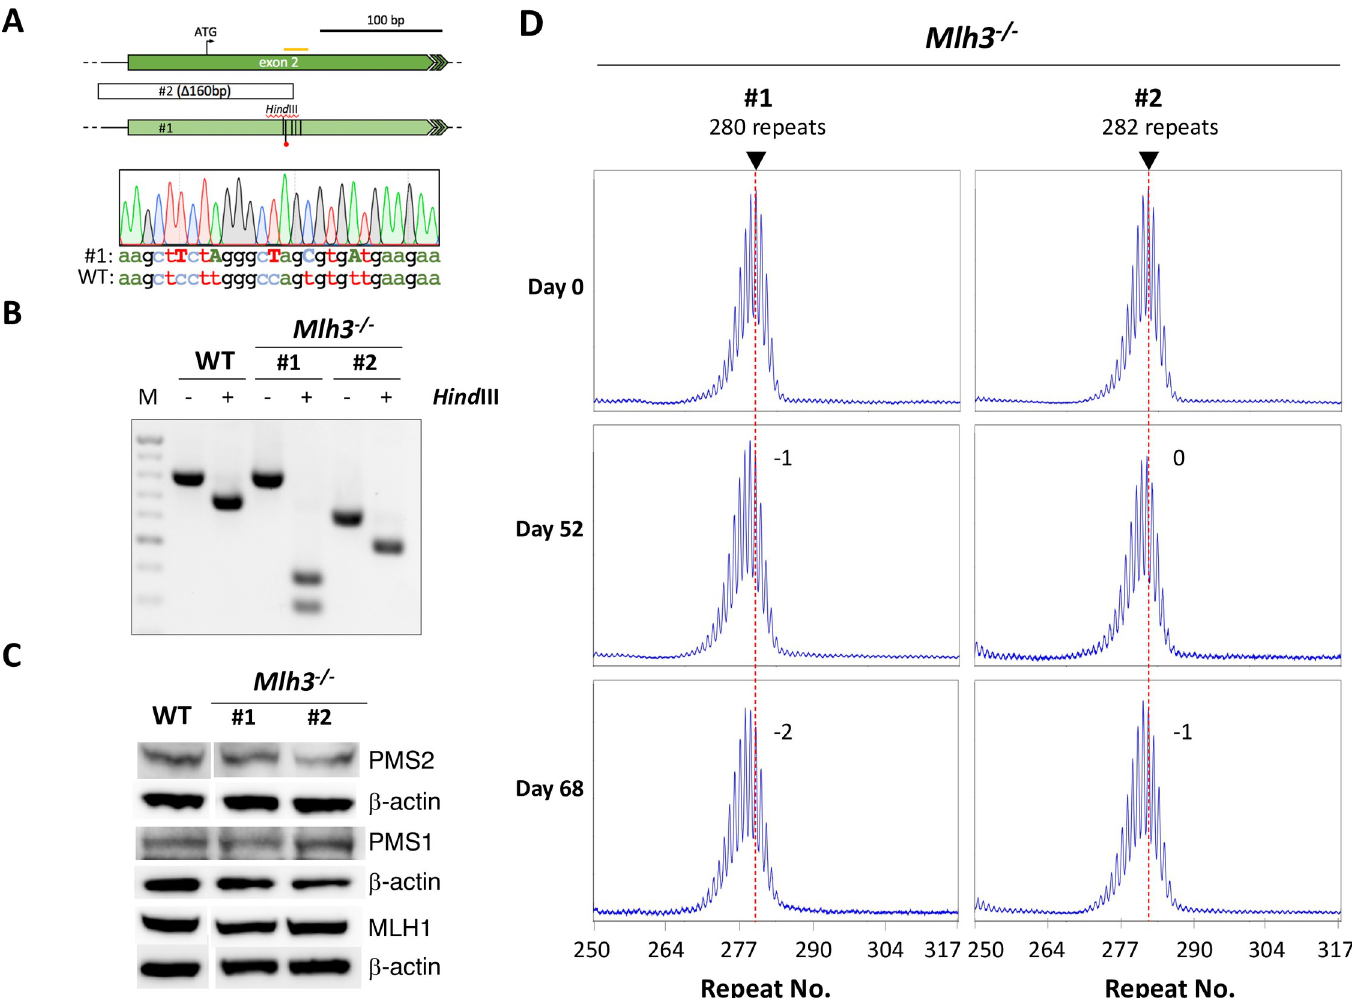
Fig 2. Generation and analysis of Mlh3 -/- cell lines. A) Diagram of mutations generated in exon 2 (the first coding exon) of the Mlh3 locus. Orange bar: CRISPR gRNA target. The ATG indicates the initiator methionine. Light-shaded arrow: HDR-edited exon in Mlh3 -/- #1 mutant line. Vertical lines within the arrow indicate the position of HDR generated point mutations. The red dot indicates the stop codon introduced by point mutations. The red squiggle marks the position of the HDR ssODN. Open box: extent of CRISPR-induced deletion in #2 line. The sequencing trace shows the sequence of this region in line #1 with the bases shown in capitals being the edited bases. B) PCR and restriction digestion of DNA from Mlh3 +/+ cells and two Mlh3 -/- CRISPR-edited cell lines. Hin dIII cuts the PCR products from WT and mutant lines to produce a 95 bp fragment (not shown). It also makes a second cut in the PCR product from the HDR-edited allele of line #1, but not the deleted allele of line #2. M: 100 bp molecular weight ladder. C) Western blot demonstrates that the loss of MLH3 does not affect the levels of MLH1, PMS1 or PMS2. Note that the lanes shown here are from the same blots shown in Figs 4C and 5C. D) Repeat PCR profiles of the two Mlh3 -/- lines after 0, 52 and 68 days in culture. The red dotted line on each profile indicates the major allele present in the cell population at day 0. The numbers adjacent to the profiles indicate the change in the repeat number relative to day 0.